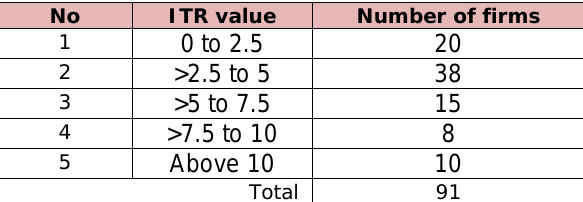
Table 8. “Distribution of ITRs of